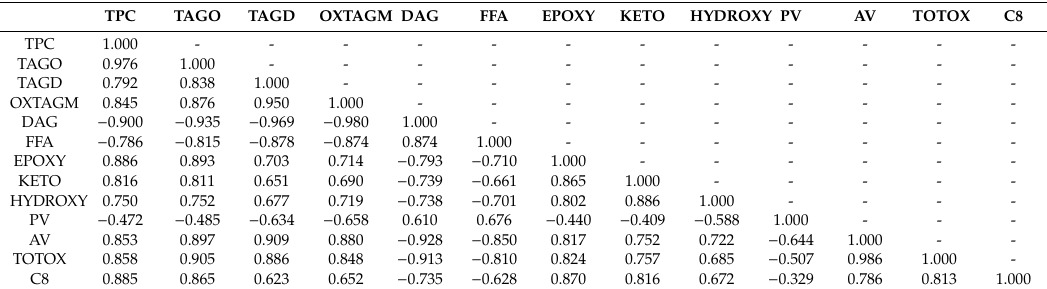
Table 5. Correlation coe ffi cients ( r ) for analytical